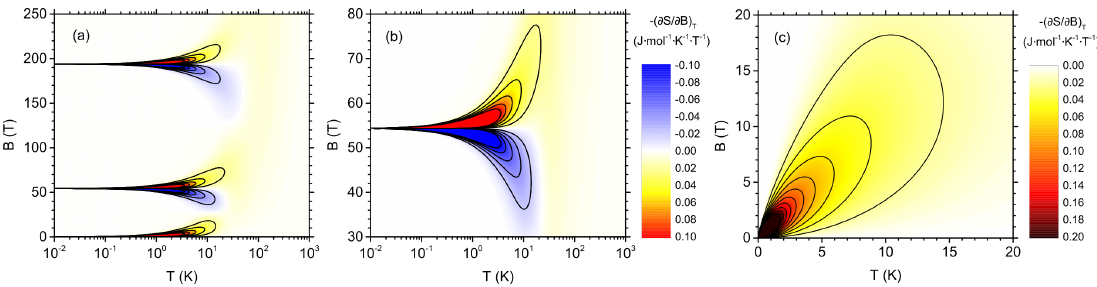
Figure 7. Isothermal entropy change as a function of temperature between the varying values of initial magnetic field and the final magnetic field of 1 T.